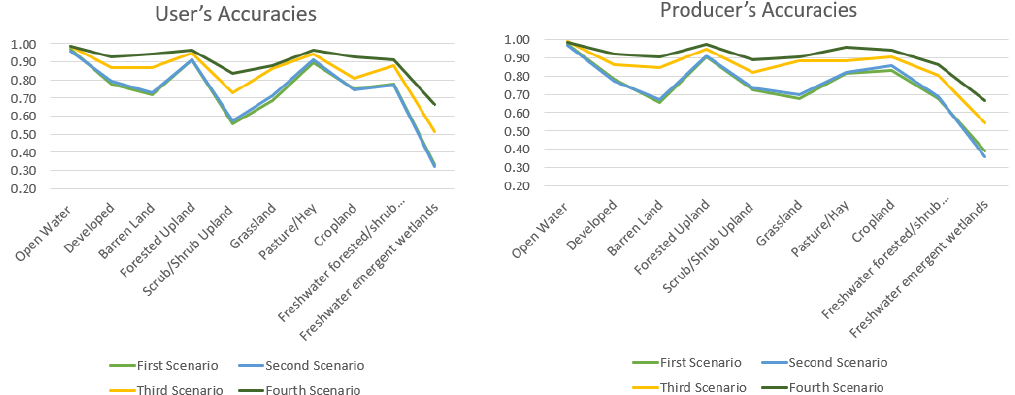
Figure 4. User’s and producer’s accuracies of defined scenarios.